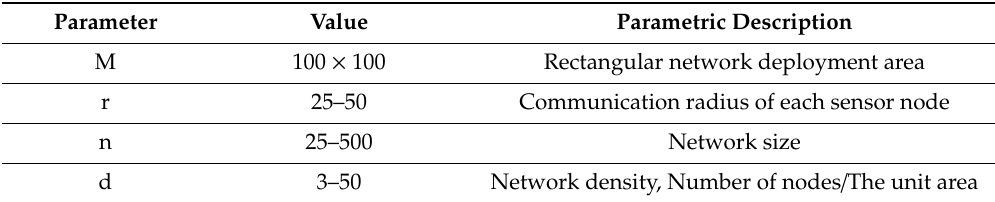
Table 1. Simulation parameters